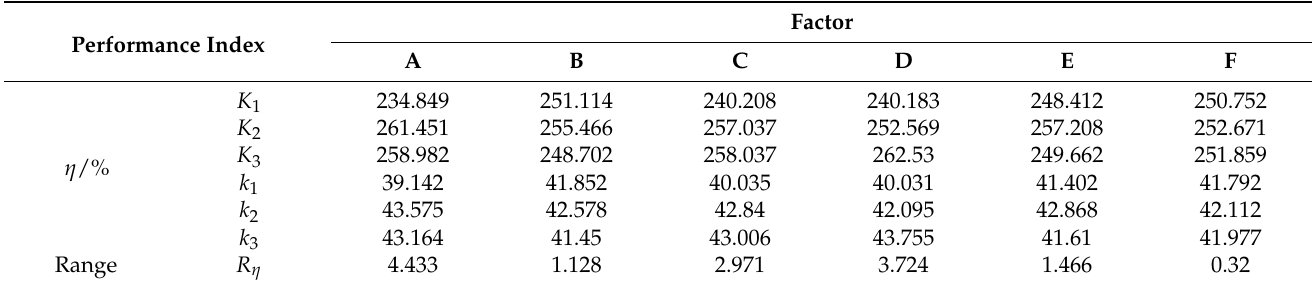
Table 4. Range analysis of pump efficiency.